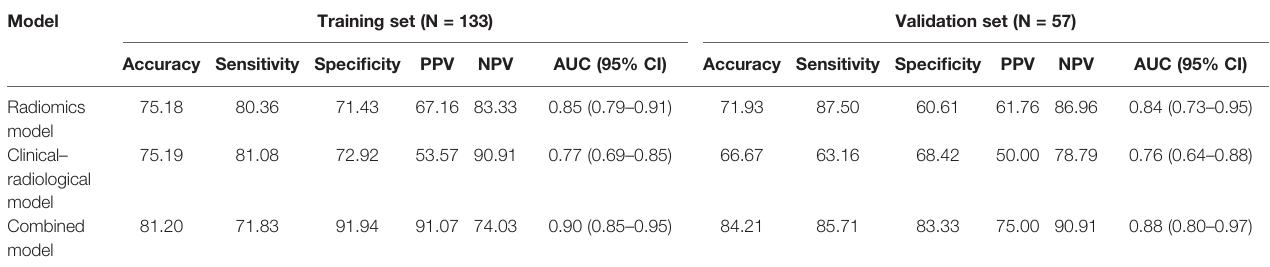
TABLE 3 | Predictive performance of the three